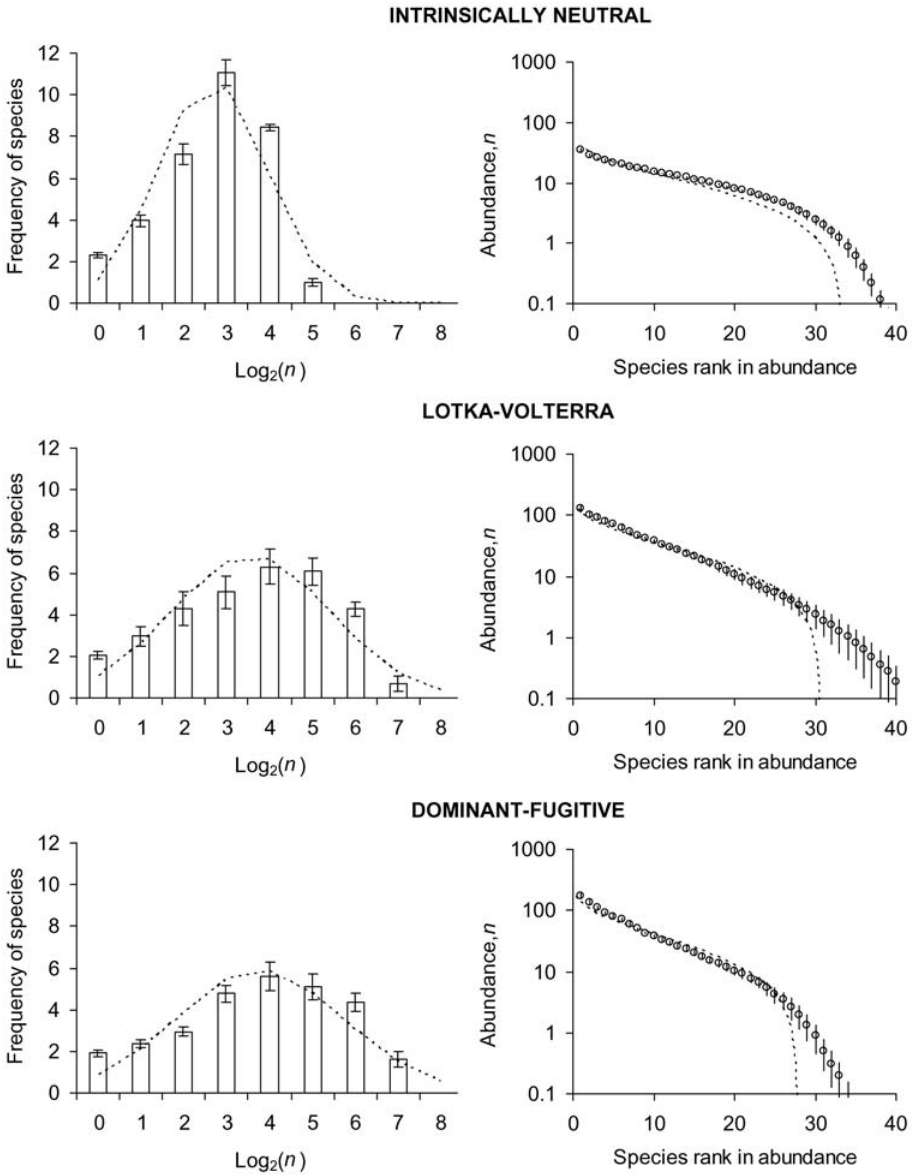
Figure 3. Simulated steady-states of species-abundance distributions (SADs). From top to bottom, graphs show average patterns for intrinsically neutral, Lotka-Volterra, and dominant-fugitive communities. SADs each show mean 6 s.e. of six replicate communities with carrying capacity K =1000 habitable patches. Frequencies are compared to log-normal (left-hand column) and MacArthur’s broken-stick (right-hand column). See Methods for input parameter values and the process of random species